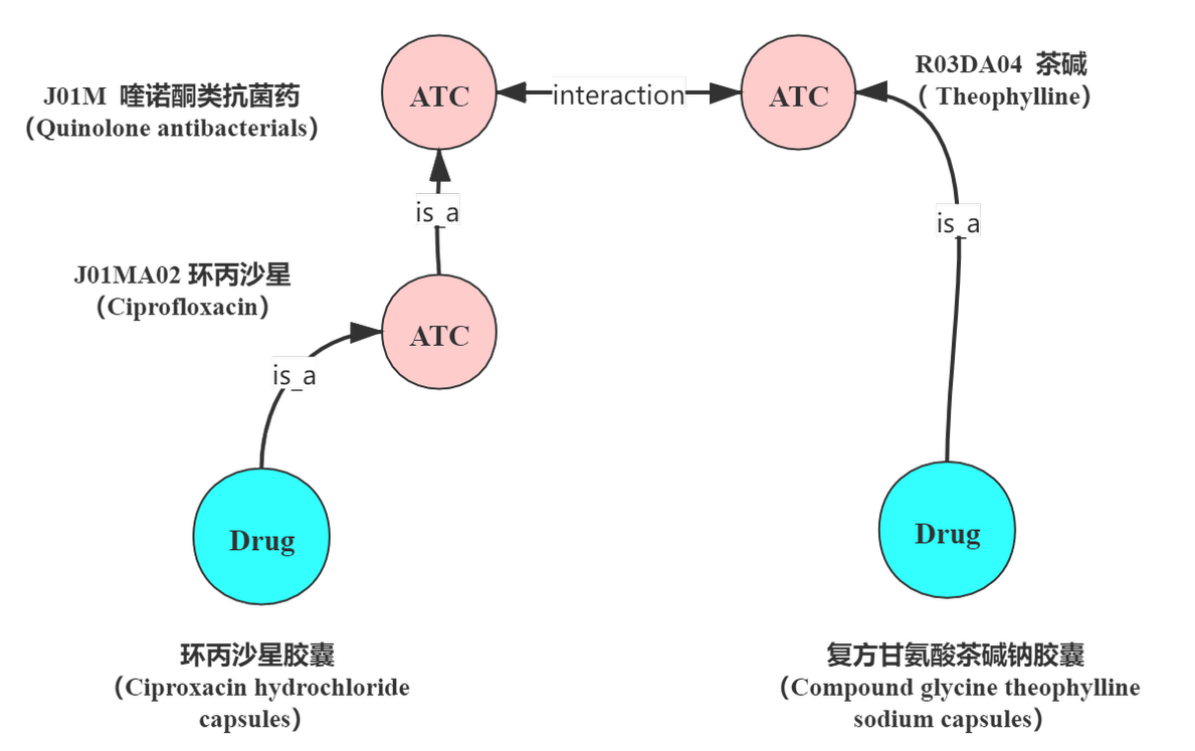
Figure 10. Example of graph query and graph reasoning. ATC: Anatomical Therapeutic